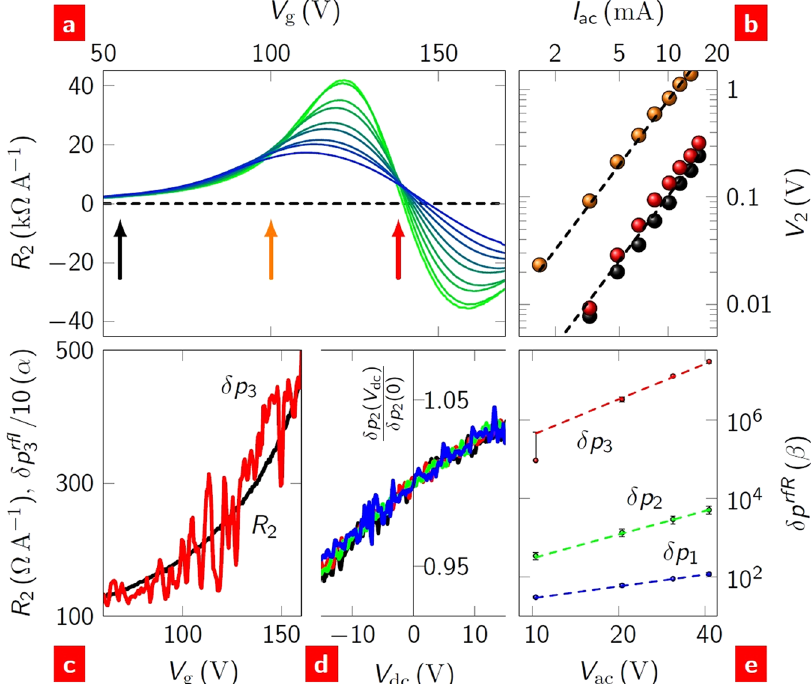
Figure 6. Third harmonic generation. ( a ) Second-differential resistance as a function of gate voltage of a back- gated FET immersed in liquid helium ( T = 4.2 K). The curve colour ranges from green at P = 0.007 W to blue at P = 0.7 W (not in equal steps). ( b ) The voltage drop across the device at f 2 as a function of ac bias. The data (symbols) are taken at the gate voltages indicated by identically coloured arrows in a ; the dashed lines are the expected I ac2 dependence. ( c ) R 2 ( V g ) in ambient conditions at P = 0.7 W shown together with the simultaneously 3 (measured at f = 42 kHz and measured current-normalised third harmonic sound pressure, δ δ = p p I /( /2) I 3 3 3 ac r = 25 mm). α µ ≡ − − PamkHz A 1 3 . ( d ) δ p 2 as a function of dc bias, normalised to its value at V dc = 0. Curves at four ac biases: 10 V (black), 20 V (red), 30 V (green) and 40 V (blue). ( e ) First, second and third harmonic sound pressures as a function of ac bias. Each datum point is an average over a range of frequencies 10 < f < 14 kHz and dc biases − 34 < V dc < + 34 V. The dashed lines are the predicted I n dependences: n = 1 (blue), n = 2 (green) and ac n = 3 (red). β µ ≡ Ω −